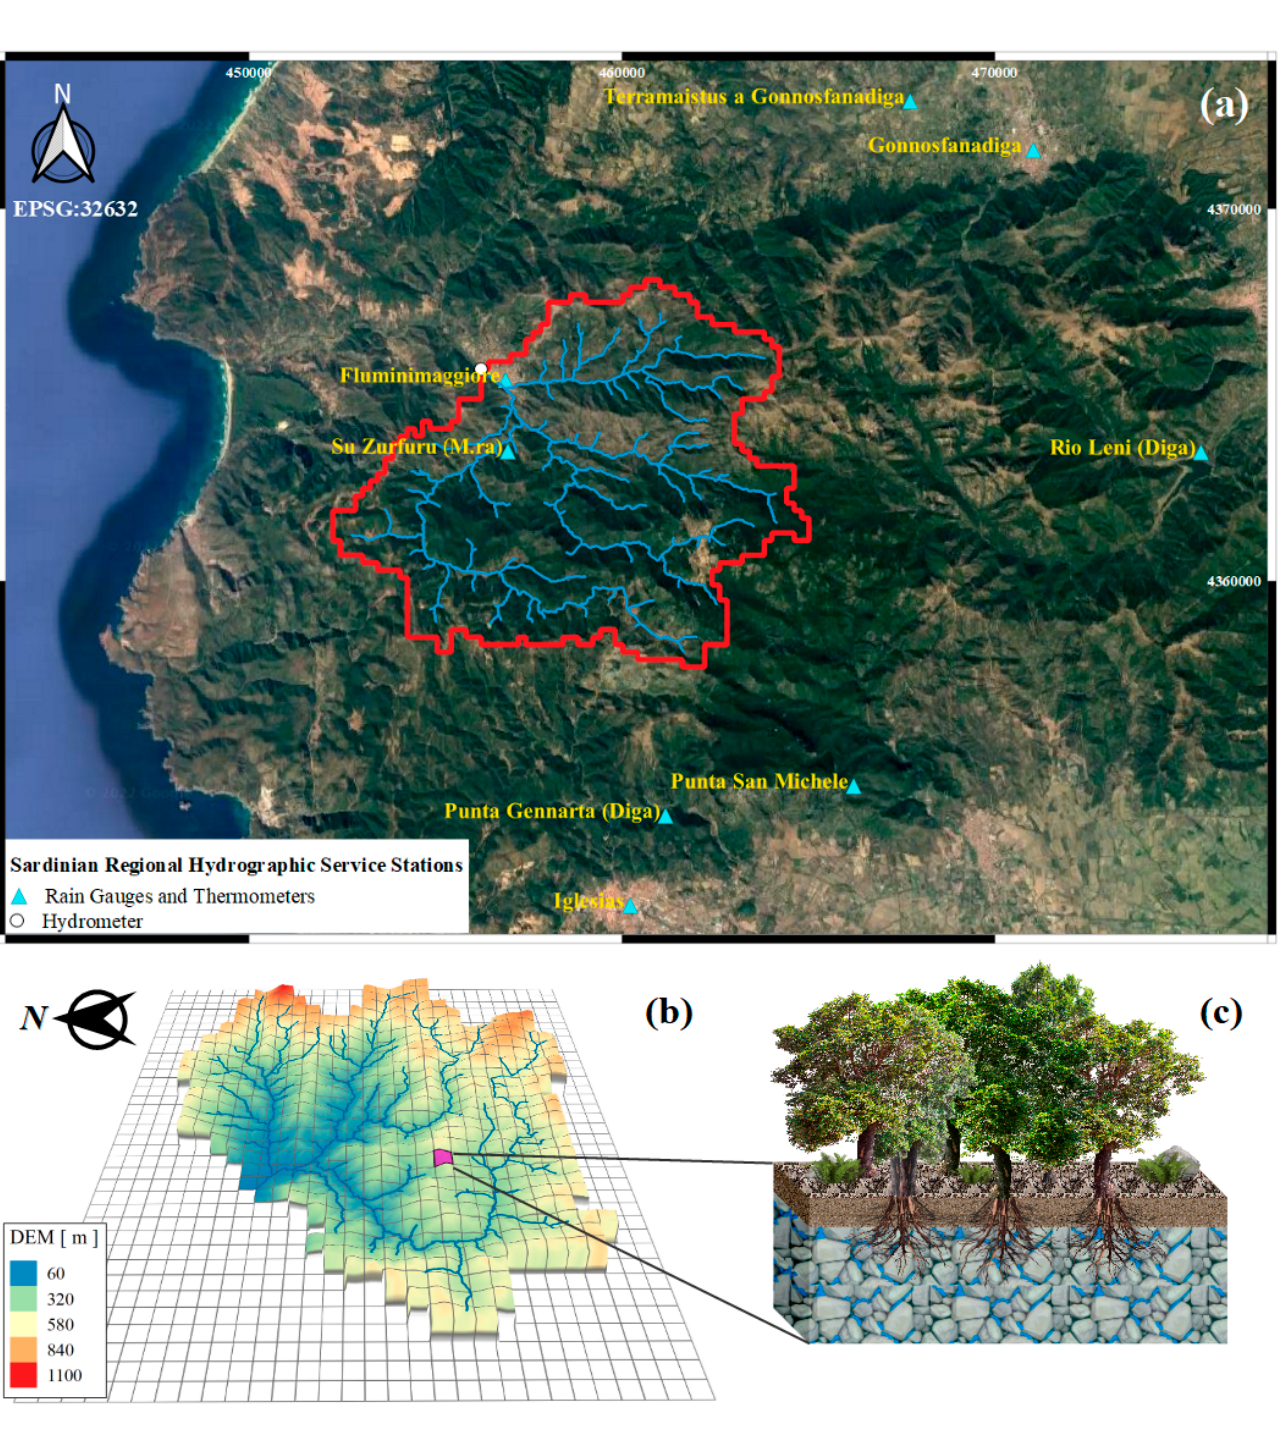
Figure 2. The Rio Fluminimaggiore river: ( a ) basin with the river network and the position of the meteorological stations and hydrometer; ( b ) digital elevation model (DEM) of the basin; ( c ) model scheme of the soil layers and vegetation for each basin cell.